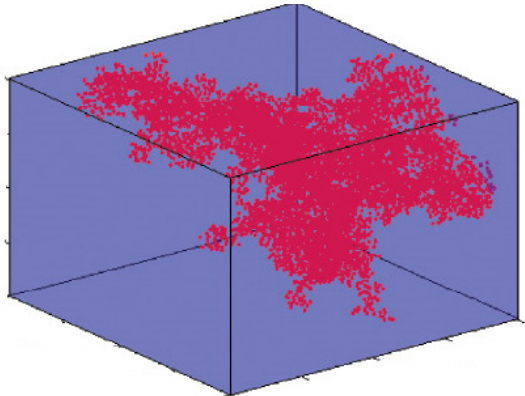
Figure 1. Schematic representation of connected nanoparticles (filler network) in a nanocomposite.